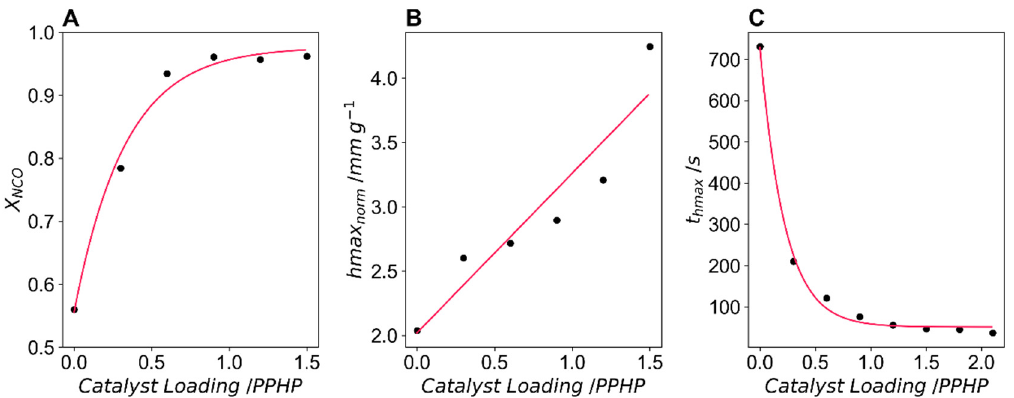
Figure 3. ( A ) Isocyanate conversion as a function of catalyst loading with the solid line indicating an exponential fit of the data. ( B ) The normalised maximum height (height divided by foam mass) of the foam as a function of the catalyst loading with the solid line indicating a linear fit of the data. ( C ) The time taken to reach maximum height as a function of catalyst loading with the solid line indicating an exponential fit of the data.